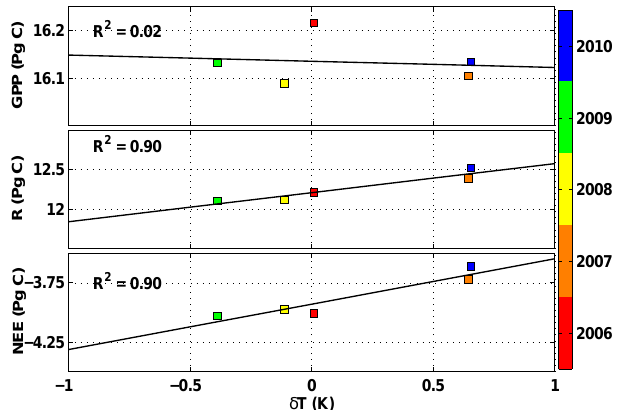
Fig. 9. The SiB 2006–2010 GPP (top), ecosystem respiration (mid- dle), and NEE (bottom) integrated over the growing season (June, July and August) and over the northern midlatitudes (30 ◦ N to 60 ◦ N), plotted as a function of the respiration-weighted surface temperature anomaly. The colors indicate different years. The res- piration and NEE fields have the most significant correlation with respiration-weighted temperature. The GPP does not have a signifi- cant